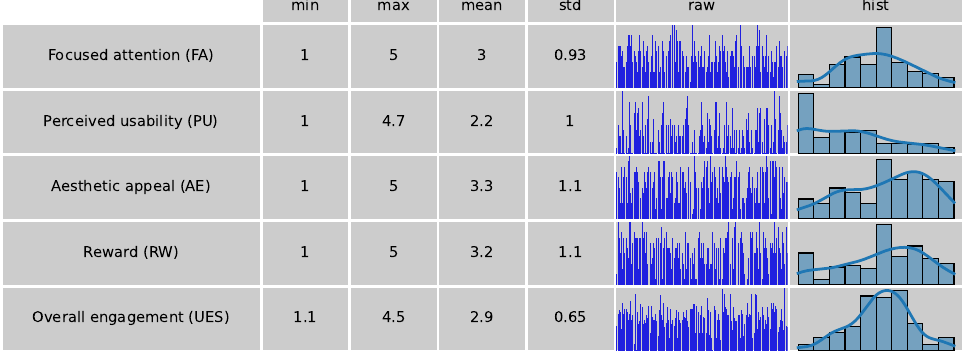
Figure 2. Basic statistics for ground truth data collected using UES-SF. The table columns represent the minimum, maximum, mean, and standard deviation for each dimension. The last two columns present a randomized bar graph of raw consecutive values of the engagement dimensions for each video rating and their histograms.